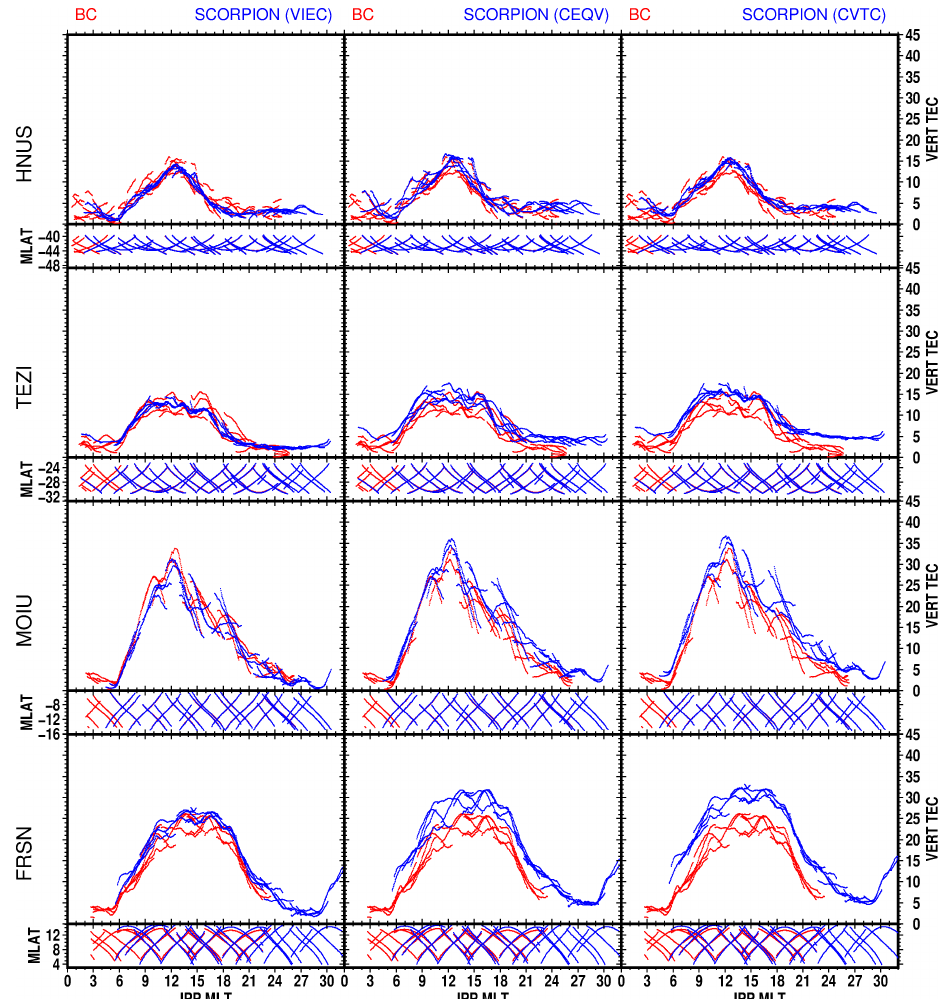
Figure 6. Overlays of SCORPION vertical TEC (blue) and BC/ISR vertical TEC (ionosphere and plasmasphere) (red), for SCORPION VIEC (ionosphere only) in the left column, CEQV (composite equivalent vertical ionosphere and plasmasphere) in the center column, and CVTC (composite vertical ionosphere and plasmasphere) in the right